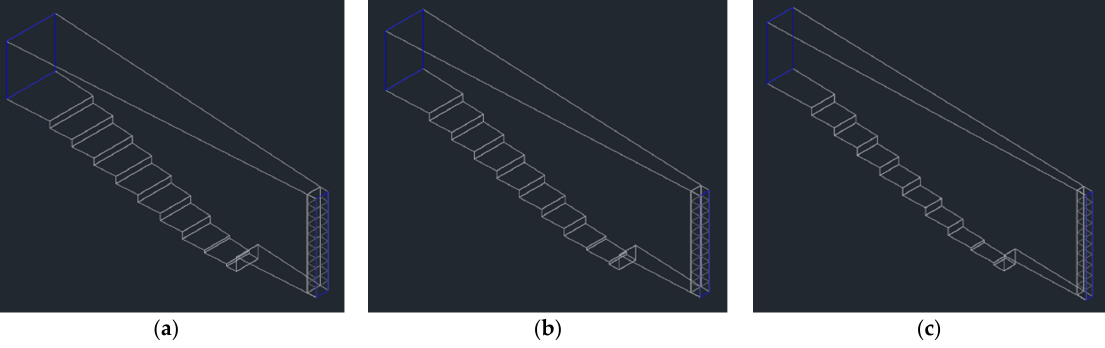
Figure 7. Scheme of the auditorium construction methodology, using a two-dimensional horizontal section. ( a ) Case A, ( b ) Case B, and ( c ) Case C.